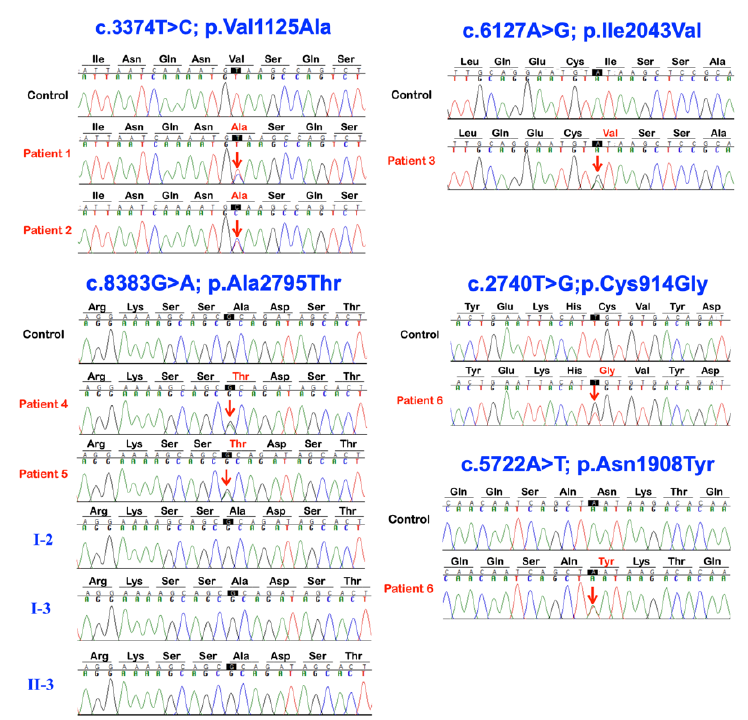
Figure 2. ( A ) Patient 4. Periapical radiograph showing double mesiodentes (inverted) (arrows). ( B ) Patient 5. Panoramic radiograph showing a mesiodens (arrow) and taurodontism (asterisk). ( C ) Patient 6. Panoramic radiograph showing double mesiodentes (arrows) and taurodontism (asterisks).